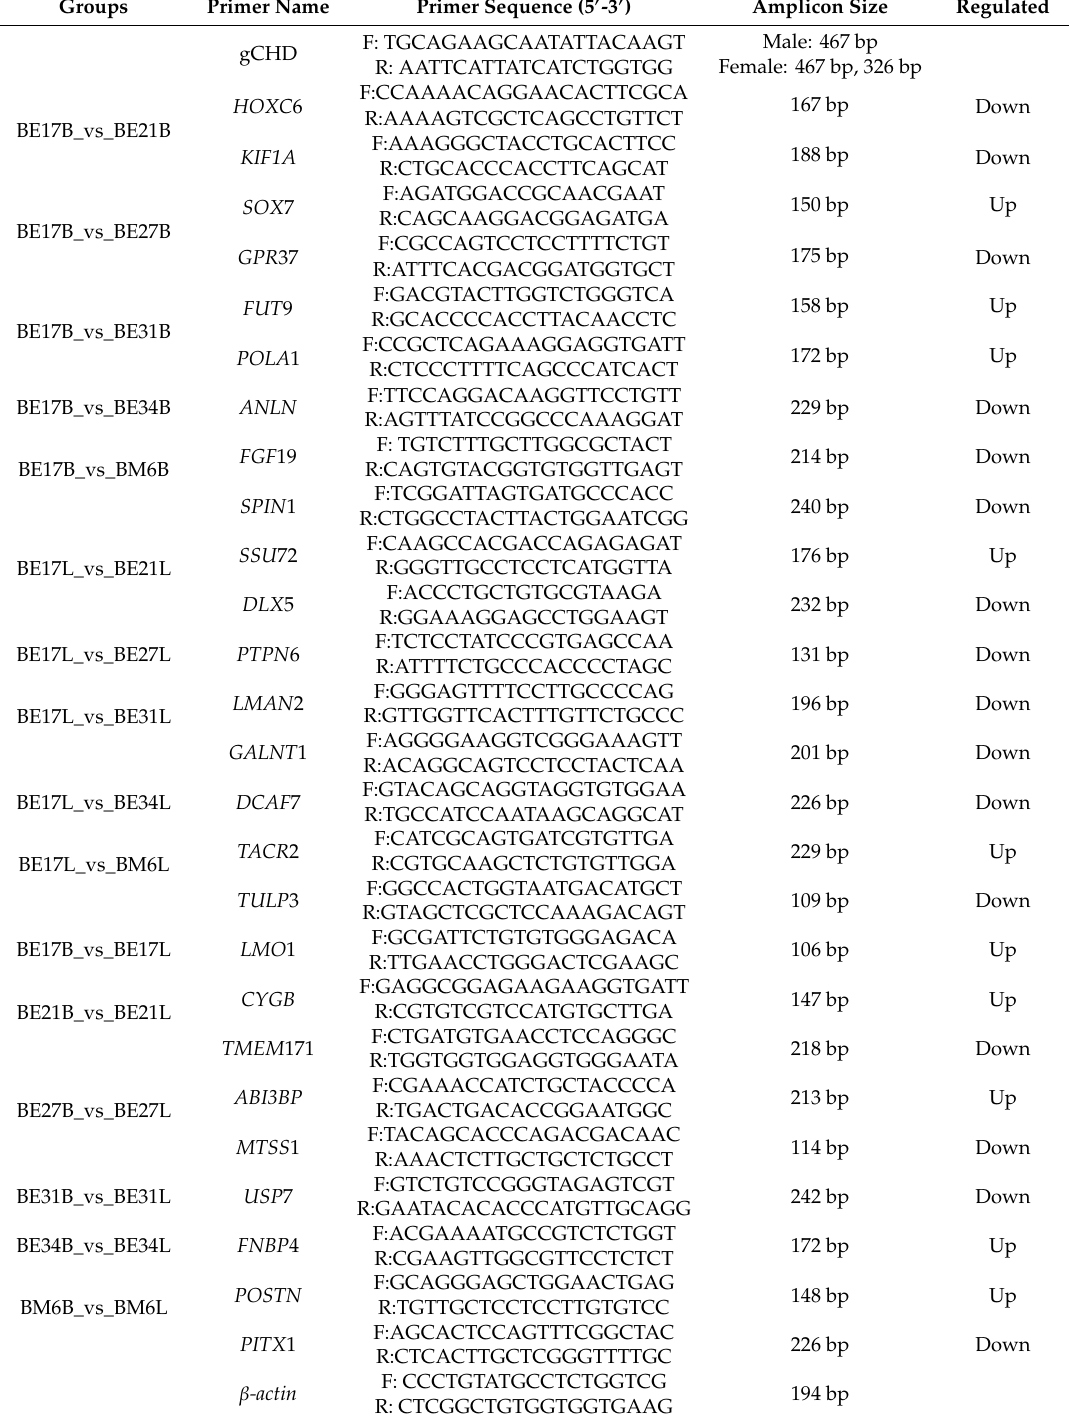
Table 1. qPCR primer sequences of black Muscovy